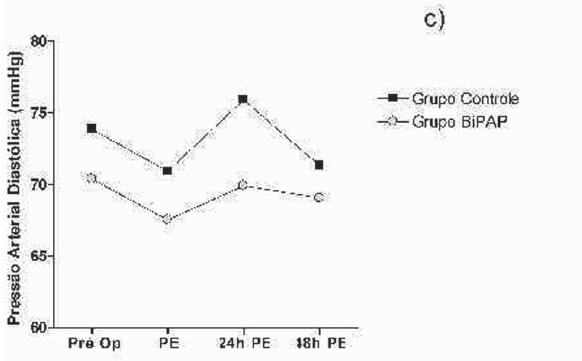
Fig. 6 – A: Evolução das medidas da Frequência Cardíaca no pré- operatório, pós-extubação imediata, 24 e 48 horas pós-extubação em média, nos grupos Controle e BiPAP. Pré-op: Pré-operatório; PE: Pós-extubação (P<0,001 intragrupos; P=0,123 intergrupos); B: Evolução das medidas da Pressão Arterial Sistólica no pré- operatório, pós-extubação imediata, 24 a e 48 a horas pós-extubação em média, nos grupos Controle e BiPAP. Pré-op: Pré-operatório; PE: Pós-extubação. (P=0,540 intragrupos; P=0,056 intergrupos); C: Evolução das medidas da Pressão Arterial Diastólica no Pré- Operatório, Pós-extubação Imediata, 24 a e 48 a horas pós extubação em média, nos grupos Controle e BiPAP. Pré-op: Pré-operatório; PE: Pós-extubação. (P=0,358 intragrupos; P=0,224